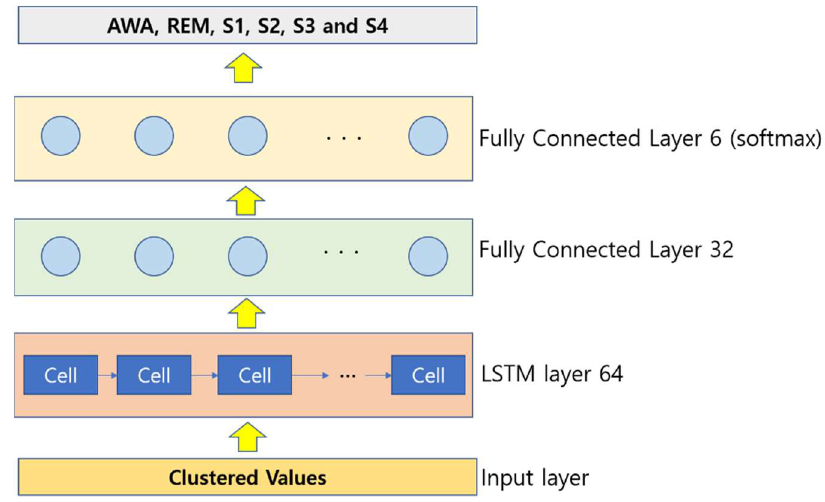
Figure 3. Illustration of the LSTM implementation. Focal